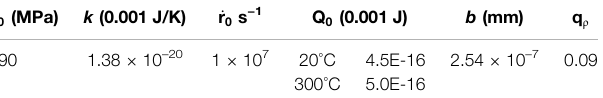
TABLE 4 | Shear strain rate related